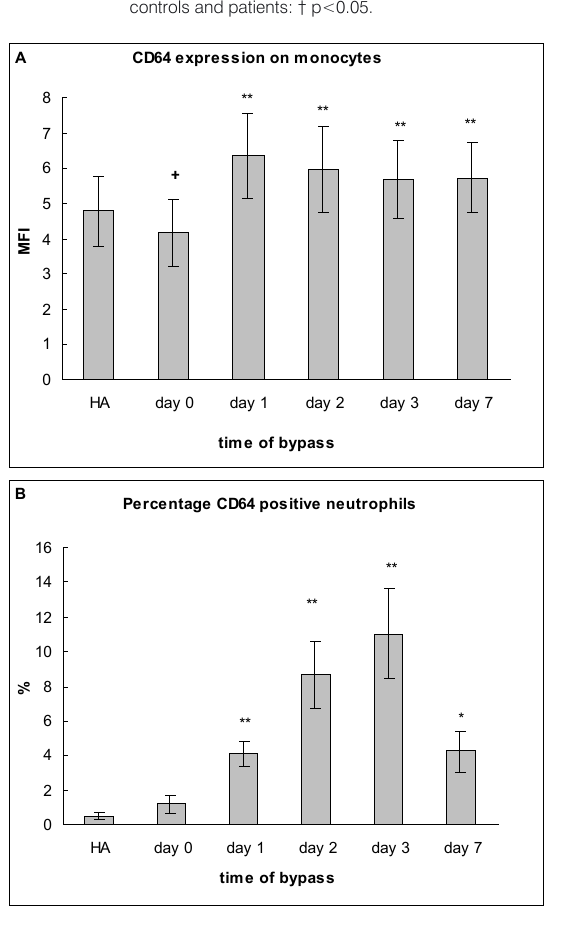
Figure 1. CD64 expression on peripheral blood leukocytes before and after CABG. Results, presented as antigen density for monocytes (A) and percentage of positive cells for neutrophils (B) are compared with controls (HA). Statistical significance: within-group comparison with baseline: * p<0.05, ** p < 0.0001; comparison between controls and patients: † p<0.05.